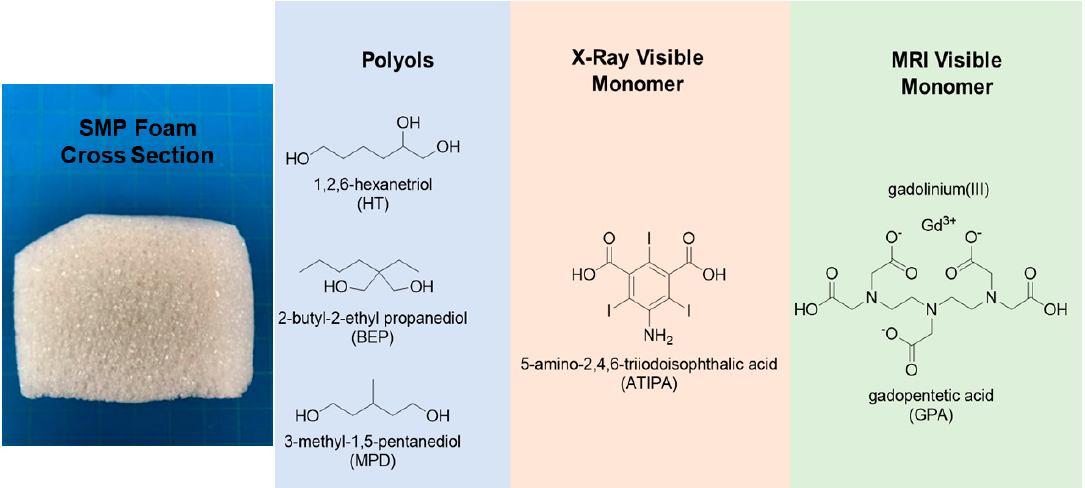
Figure 1. Left—Photograph of the cross section of a synthesized foam at current reaction scale. Right—Hydroxyl or carboxylic acid containing monomers and their role in synthesis of a porous shape memory polymer (SMP) foam with dual contrast on X-ray and MRI modalities.